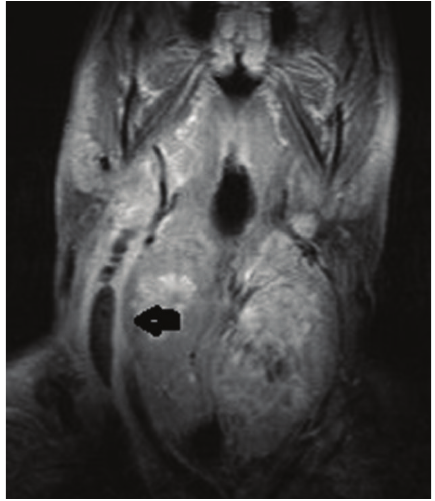
Figure 3: Neck MRI with contrast showed internal jugular venous distention with a thickened enhancing wall and filling